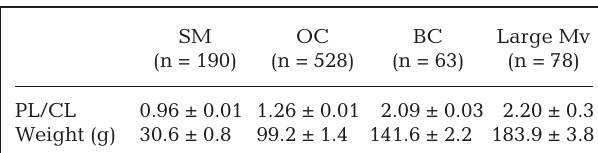
Table 1. Morphological data of Macrobrachium rosenbergii males of 3 morphotypes (SM: small males; OC: orange claw; BC: blue claw) and large M. vollenhovenii (Mv) males. PL/CL: propodus length divided by carapace length. Data are mean